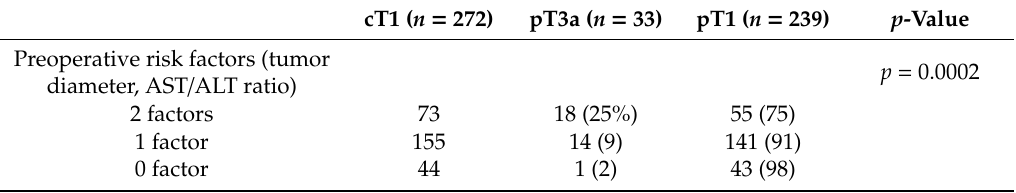
Table 4. The number of preoperative risk factors and the incidence of pathological T3a upstaging. cT1 ( n = 272) pT3a ( n = 33) pT1 ( n = 239) p -Value Preoperative risk factors (tumor diameter, AST / ALT ratio)